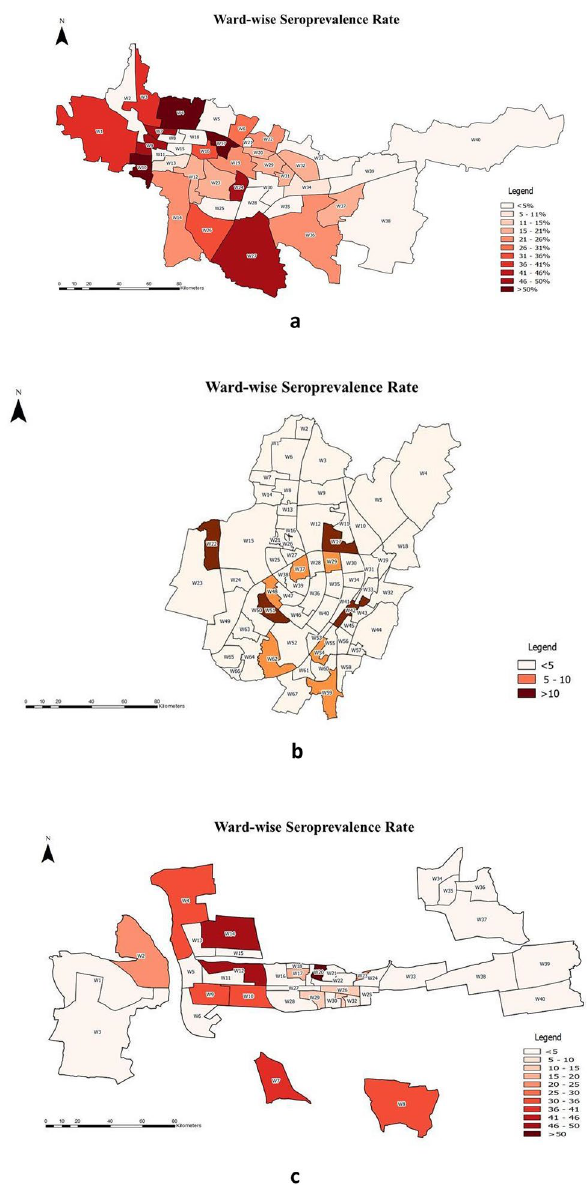
Figure 4. ( a ) Ward seroprevalence distribution of BAM. ( b ) Ward seroprevalence distribution of BBS. ( c ) Ward seroprevalence distribution of